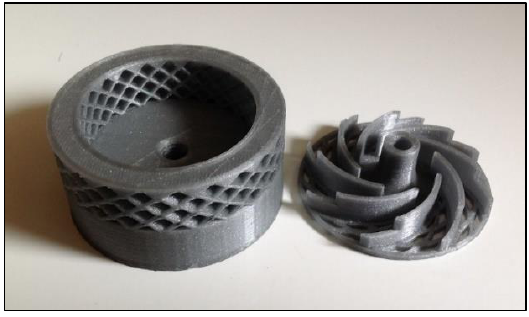
Figure 30. Micromodels of a mesh turbine (left) and a vane pump wheel (right).